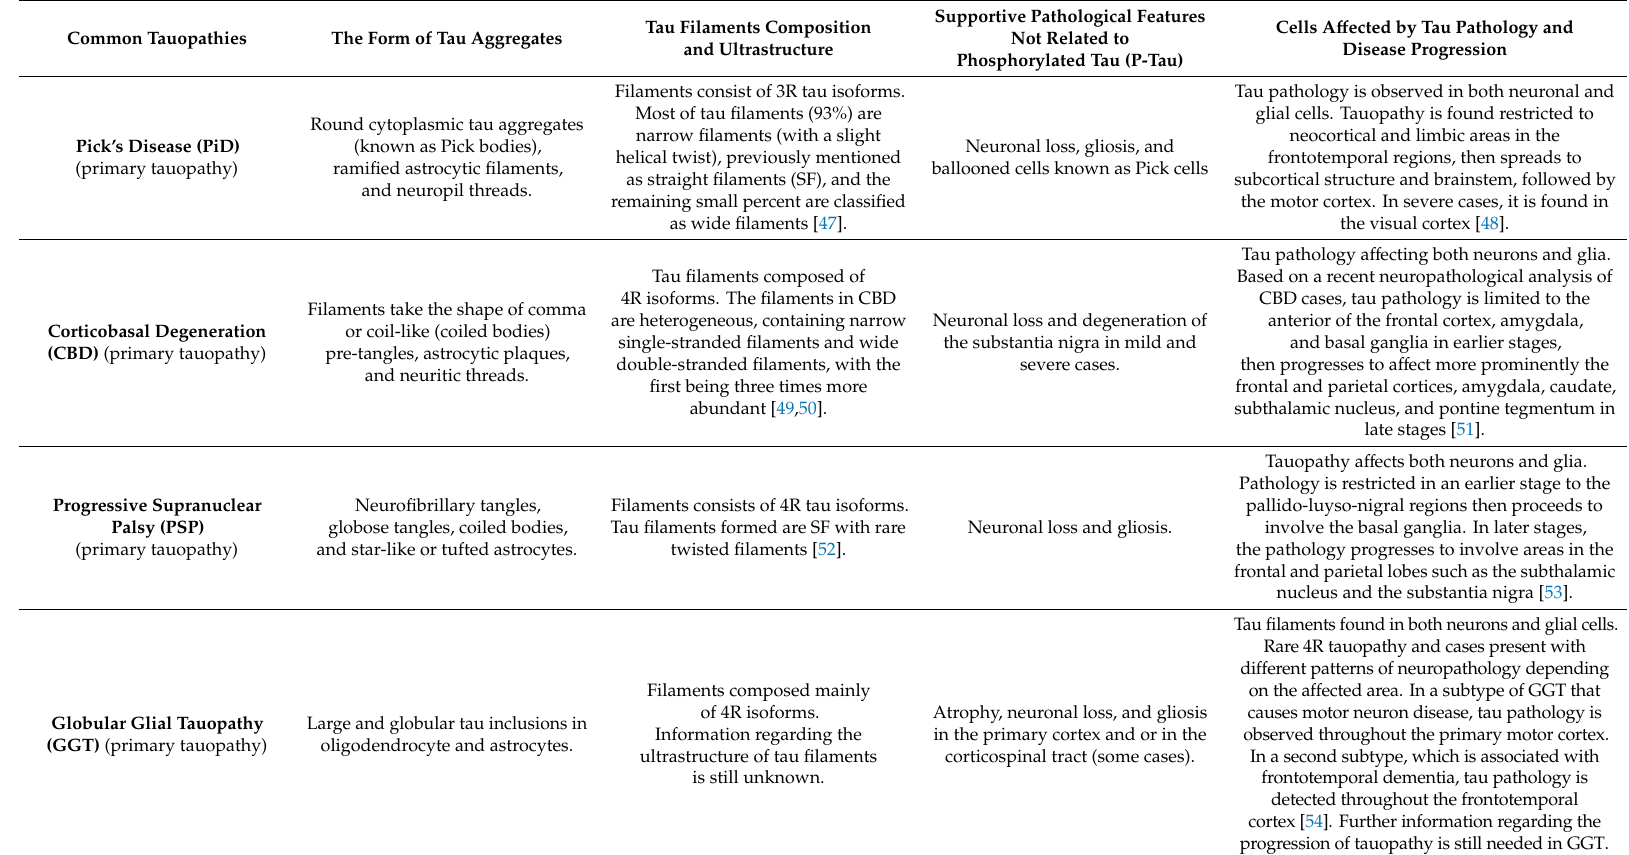
Table 1. Pathological features of major tauopathies (some information obtained from